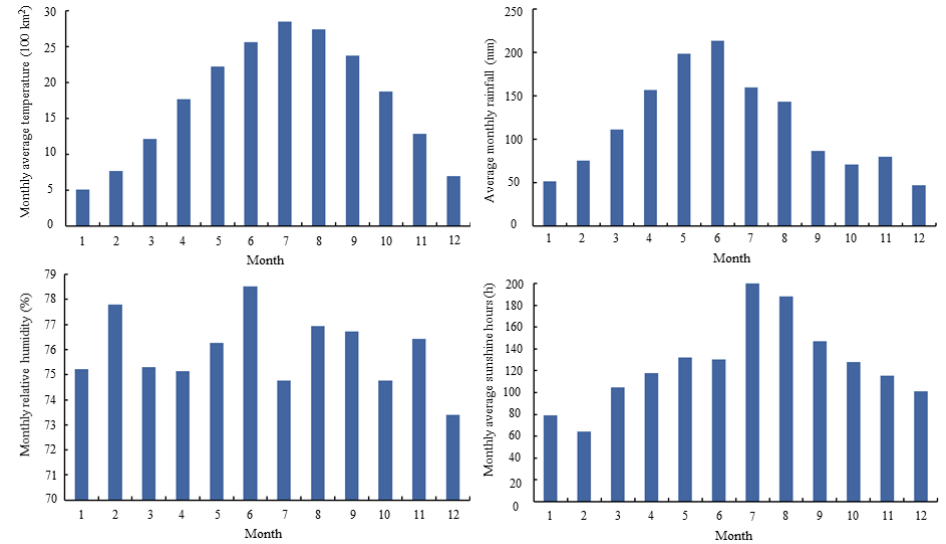
Figure A2. Monthly average temperature changes in the middle reaches of the Yangtze River from 1999 to 2015. Table A1. Stationarity analysis of the annual mean of variables from 1999 to 2015.